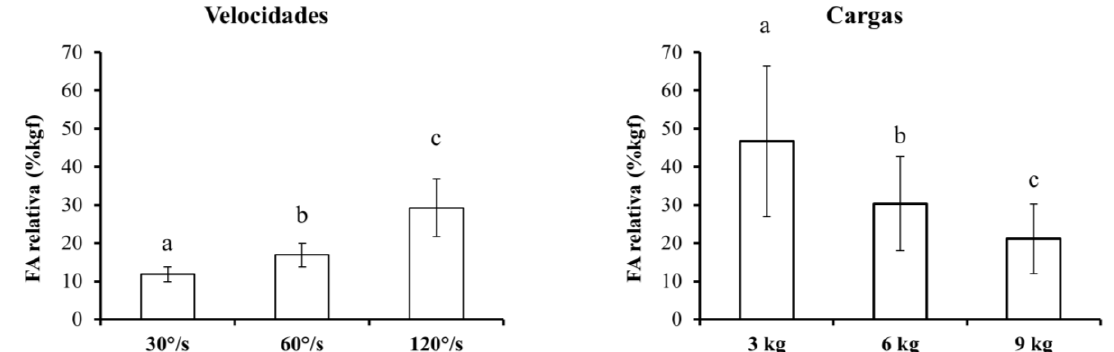
Figura 6. Resultados da comparação da FA relativa durante as três velocidades e três cargas, em valores percentuais relativos à carga utilizada em cada exercício. Letras diferentes indicam diferenças estatisticamente significativas